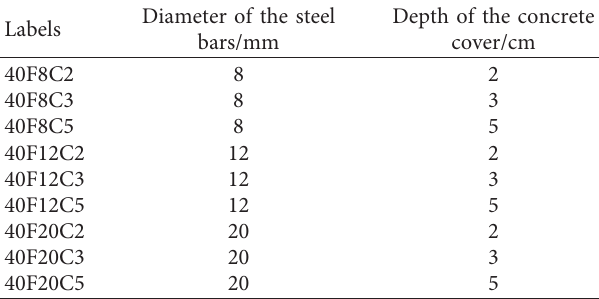
Figure 1: A lateral view (a) and a cross-sectional dimension (b) of a specimen (unit: mm), and (c) a photograph of the Table 1: Detailed information of the steel bar specimens covered by concrete.